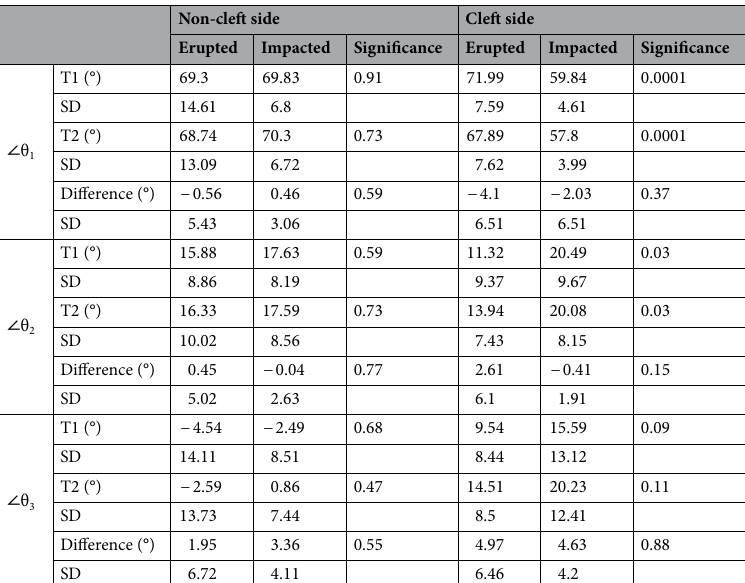
Table 2. Angle and change of canine axis of non-cleft side and cleft side at T1 and T2. ∠ θ1, ∠ θ2, and ∠ θ3 are the minimum angles between the virtual tooth axis and the XY, XZ, and YZ planes,